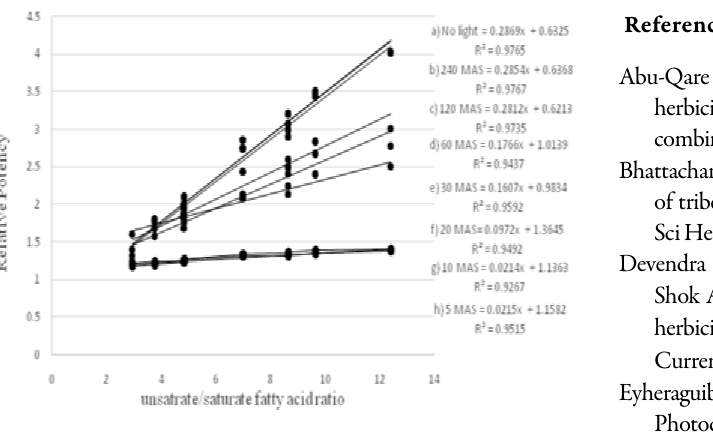
Fig. 1. Relationship between relative potency of sethoxydim (alone and in a mixture with vegetable oils), in light treatments and unsatrate/saturate fatty acid